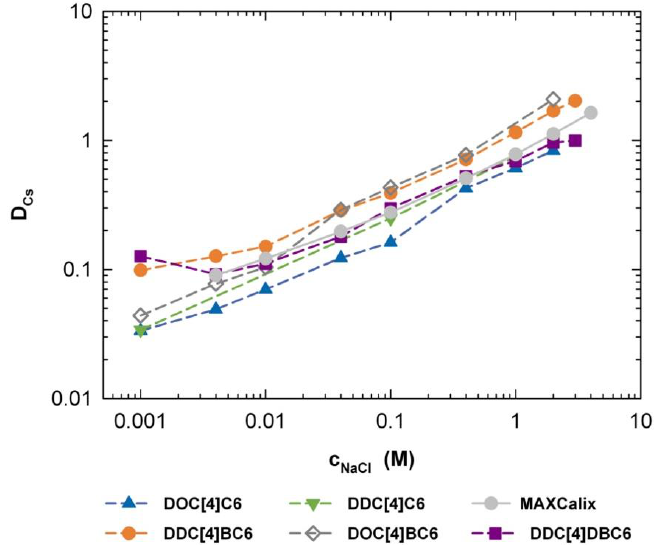
Figure 4. Cs + extraction by various mono-crown ethers. Organic phase, 0.02 M mono-crown ether in 1-octanol/n-dodecane 75/25. Aqueous phase, NaCl + 0.001 M HCl + 137 Cs (10